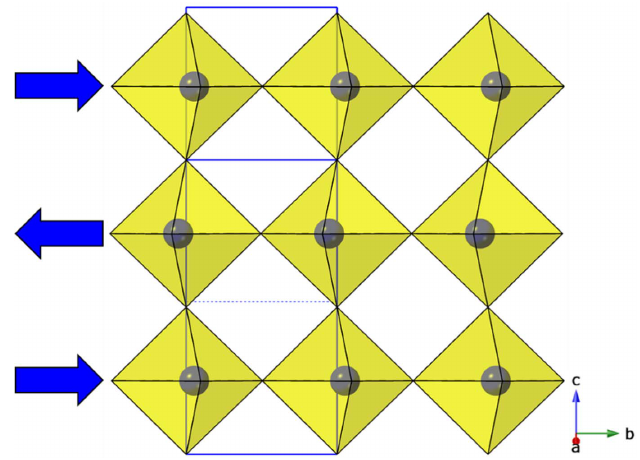
Figure 7 Antiferrodistortive displacement of Pb ions causes doubling of the c axis in nRP type [C 5 H 12 N] 2 PbCl 4